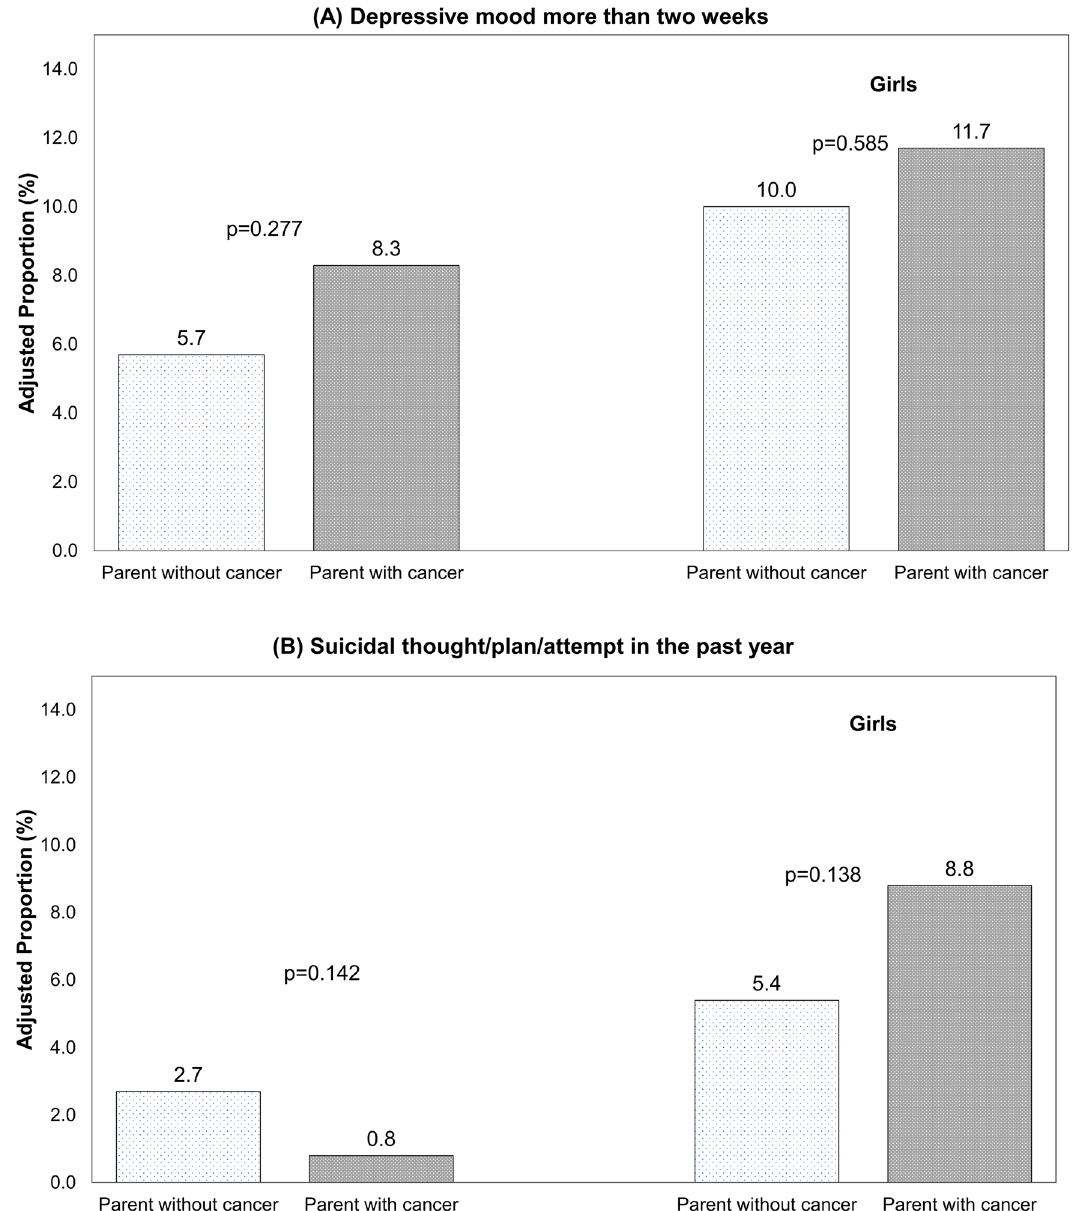
Figure 2. Comparison of depression and suicidal thought among adolescent boys and girls with and without cancer parents. ( A ) Depressive mood more than two weeks. ( B ) Suicidal thought/plan/attempt in the past